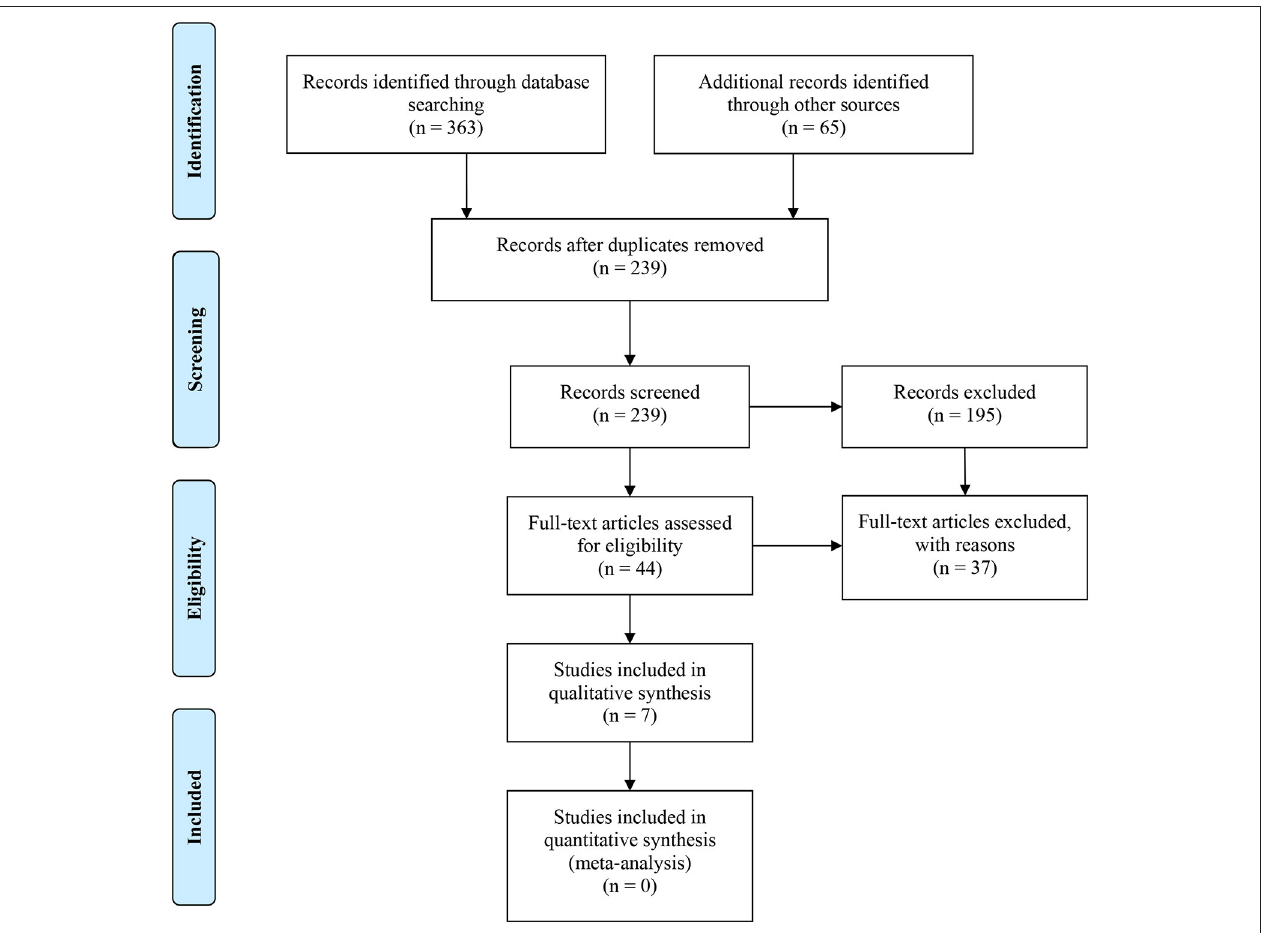
FIGURE 1 | PRISMA 2009 Flow Diagram.